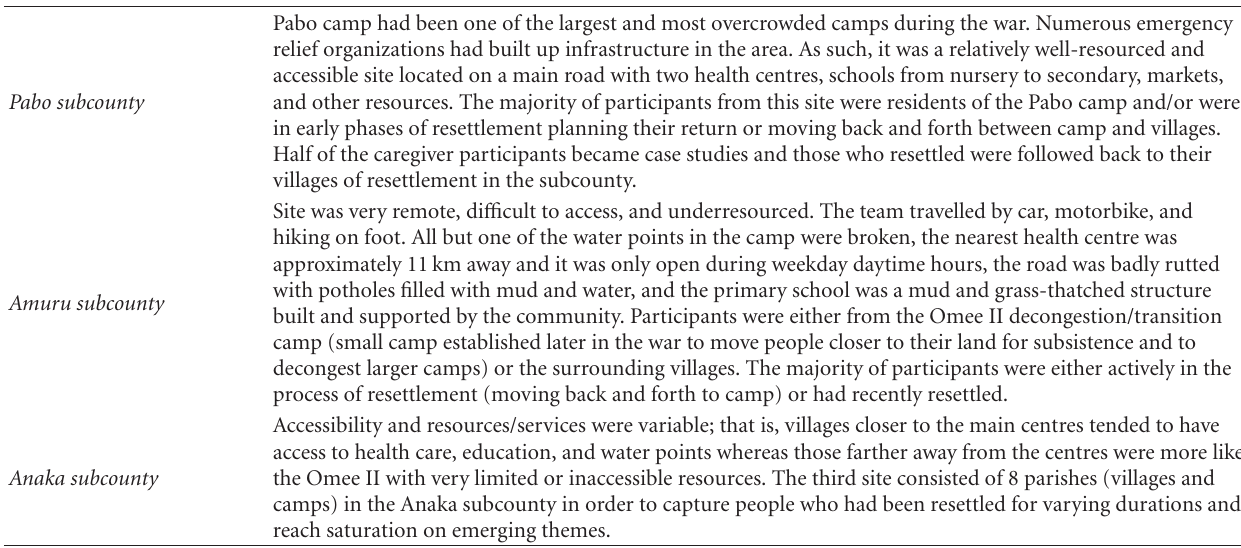
Table 1: Description of research